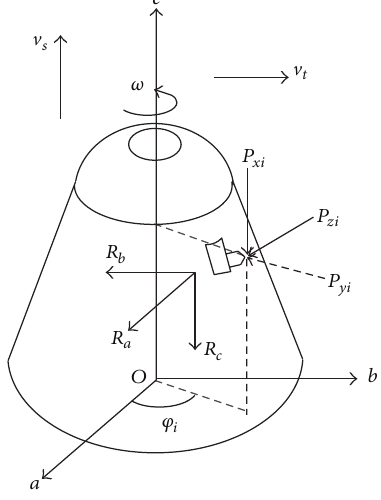
Figure 2: Load diagram of cutting